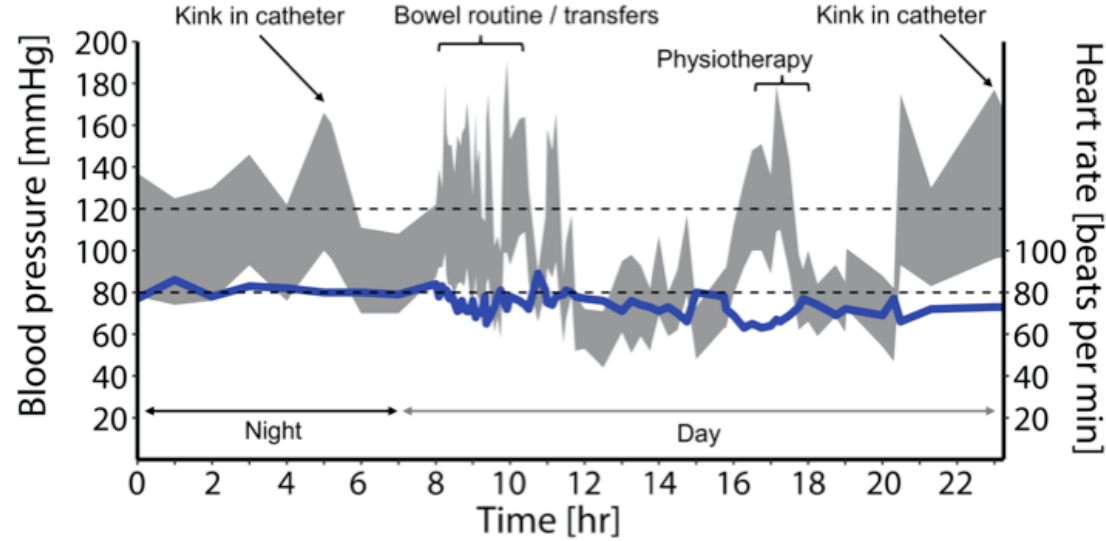
Figure 2. Ambulatory BP monitoring data collected from a research participant with a motor- complete cervical SCI (C5, AIS B). These data demonstrate transient, pendulum-like shifts in BP (in grey) in response to various stimuli throughout a normal day. Multiple episodes of autonomic dysreflexia ( n = 25) and orthostatic hypotension ( n = 33) were observed in this case, with systolic BP ranging from 71 to 180 mmHg (mean arterial pressure: 53 to 132 mmHg). Triggers for these conditions are annotated on the figure. The bowel routine in particular demonstrates aberrant BP changes, in both directions, in response to suppository insertion, digital stimulation, and pressure applied to the abdomen (autonomic dysreflexia) and transferring to and from the commode (orthostatic hypotension). Heart rate is represented by the blue solid